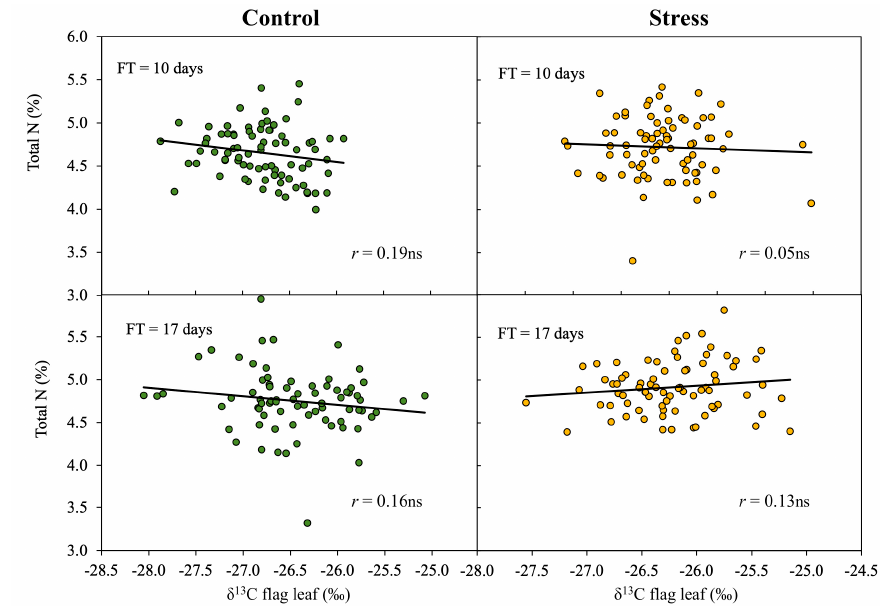
Figure 7. Linear regression of the relationship between the total nitrogen (Total N) concentration and the stable carbon isotope composition ( δ 13 C) in the flag leaf dry matter sampled before stress conditions were imposed ( δ 13 C control, right panels) and after two weeks of the last irrigation ( δ 13 C stress, left panels). Relationships were studied by considering the subset of genotypes with a flowering time of 10 (n = 76) and 17 days (n = 63). Level of significance, ns p > 0.05.